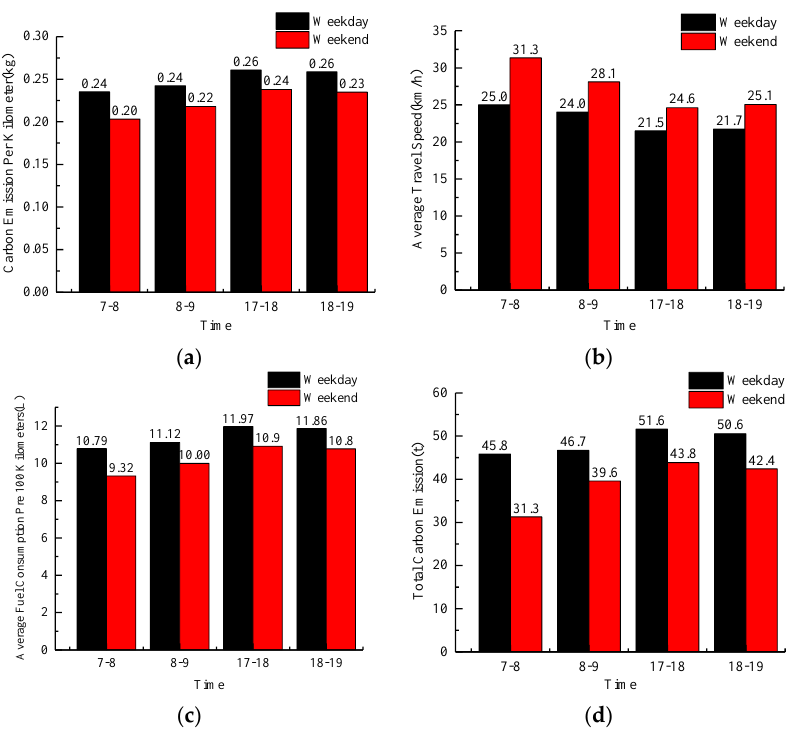
Figure 12. Temporal comparison of carbon emissions and travel patterns between weekdays and weekends. ( a ) difference in CEPK; ( b ) difference in average travel speed; ( c ) difference in average FCPOK and ( d ) difference in total carbon emissions.